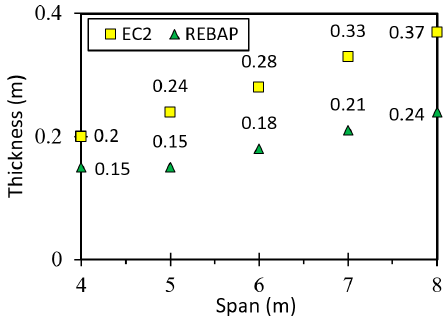
Figure 3. Minimum thickness of the square flat slab.